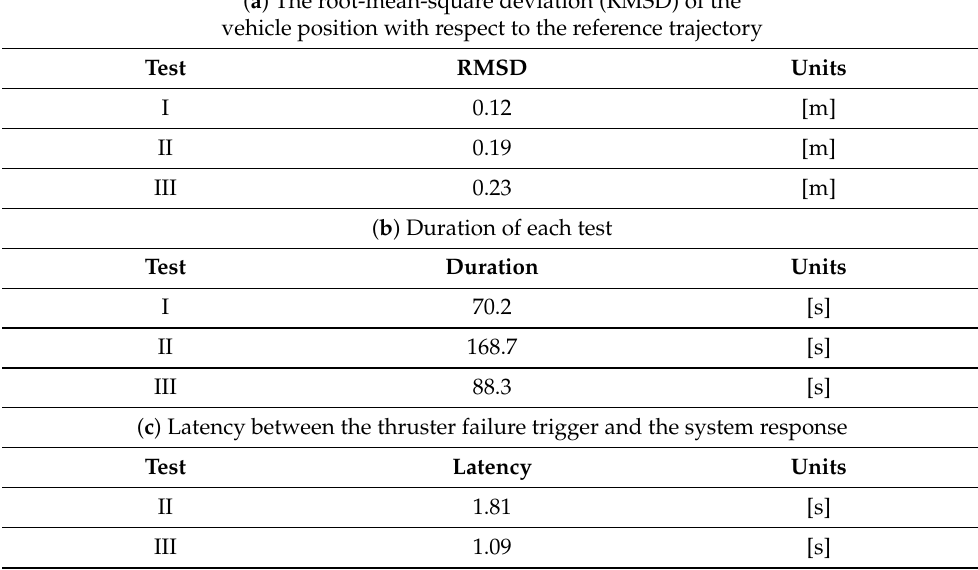
Table 3. Comparison between tests. I represent the test with all thrusters working. II represent the test with the failure of T 0 . III represent the test with the failure of T 1